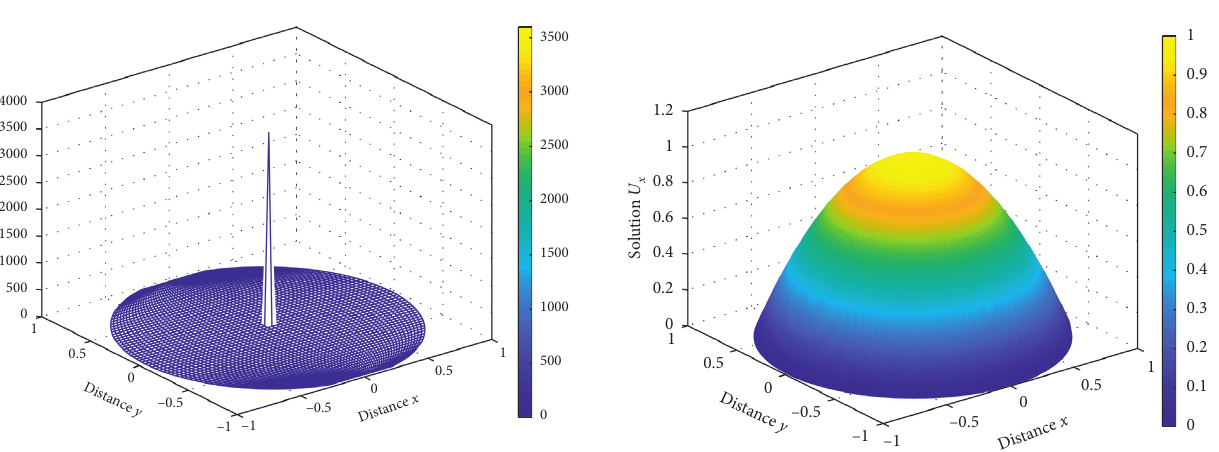
) � 2230. ex Figure 14: The exact solution at t � 0 . 01, using the Cartesian discretization.